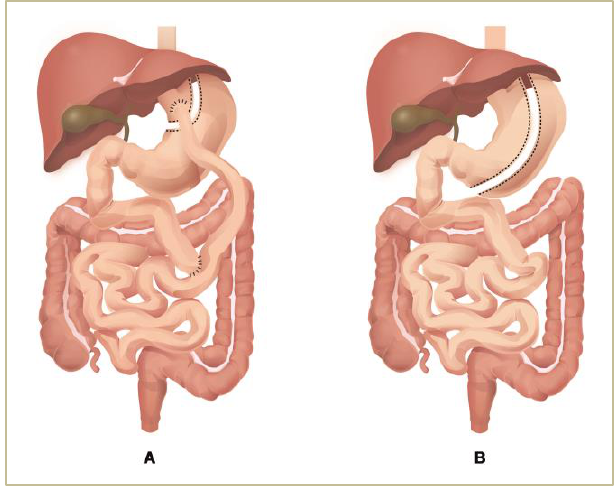
Figure 1. Most common BS procedures worldwide: ( A ) Roux-en-Y gastric bypass and ( B ) vertical sleeve gastrectomy.